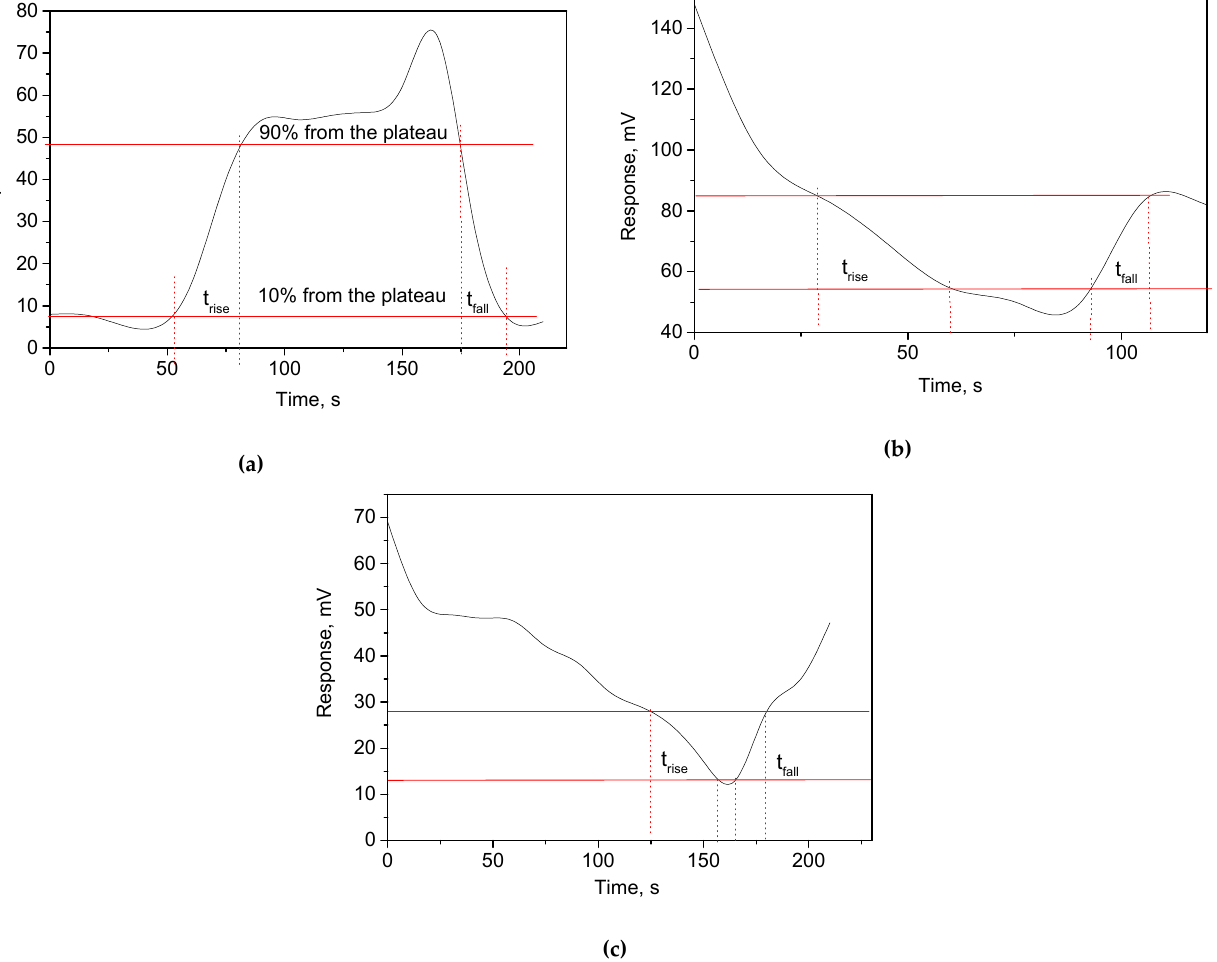
Figure 5. Response and recovery times for the ethanol concentration selected as a middle point of the linear zone of the sensors’ responses: ( a ) device 1, ( b ) device 2, and ( c ) device 3.